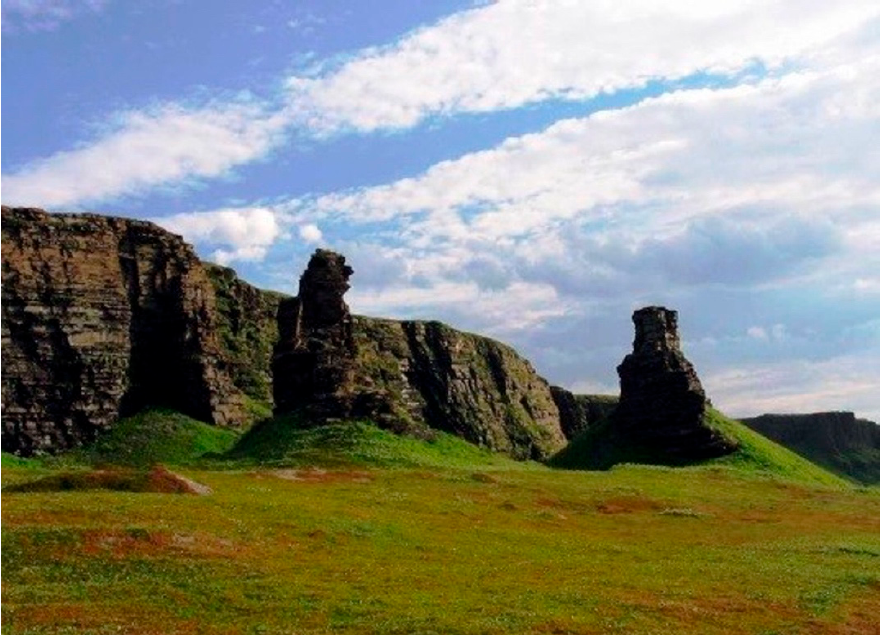
Figure 2. Rocky remains “Bratja”—an object of the post-glacial geological history of Fennoscandia. The photo is by M. Shakhnovich [39].